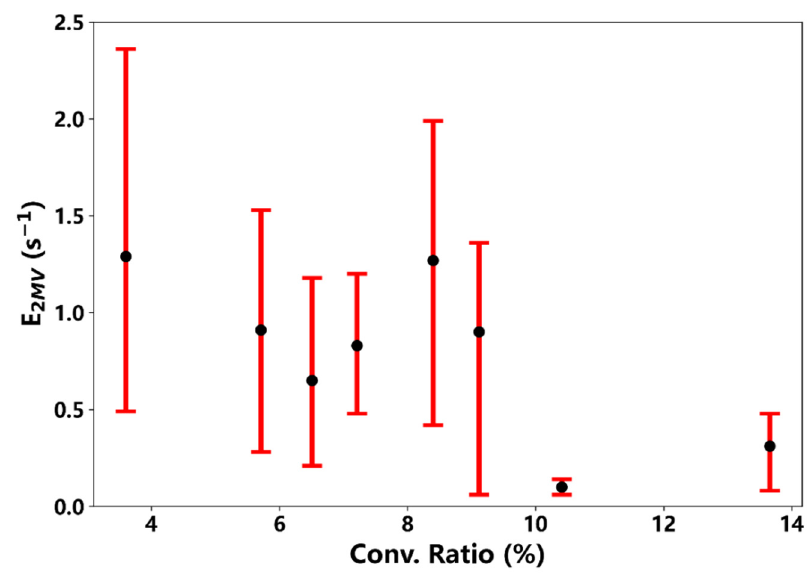
Figure 5. Plot of the evaporation rate of MV dimers vs. the apparent conversion ratio of monomers to dimers during the NPF events in this study (except those on 22 and 23 August). The black dots represent the averaged values and the error bars (red lines) represent the evaporation rates corresponding to maximum (upper) and minimum (lower) [ B ].